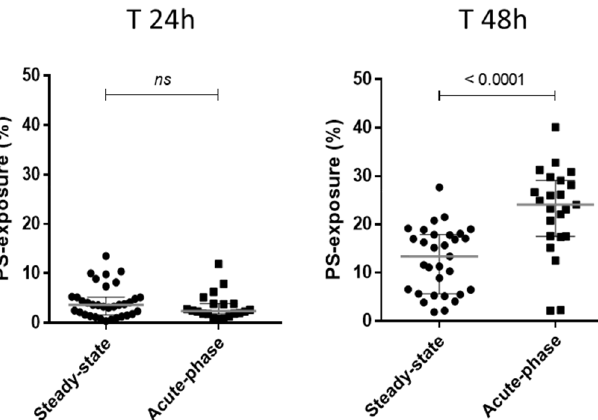
Figure 1. Phosphatidylserine-exposure on RBCs after co-incubations with sickle-cell disease patient plasmas. The results obtained concerning PS-detection on AA RBCs after the 24-hour ( T 24 h ) and 48-hour ( T 48 h ) incubations at +37 °C with SCD plasma samples, are represented considering the clinical condition of the patients (“steady-state”, n = 31 versus “acute-phase”; n = 23). The PS-exposure results obtained were 4.26 ± 3.2 % and 3.35 ± 2.7 %, respectively; at T 24 h ( p = 0.2999; left plots), 12.66 ± 6.7 % and 22.8 ± 9.03 %, respectively; at T 48 h ( p < 0.0001; right plots). P values indicated on the graphs represents results of Mann–Whitney U tests (see also: Supplementary Figures S1 and S2, Table S1).